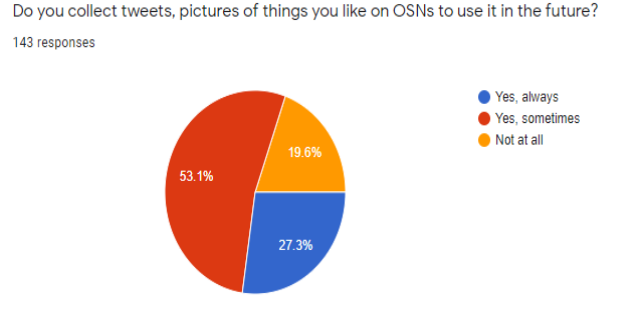
Figure 4. Response from an online survey